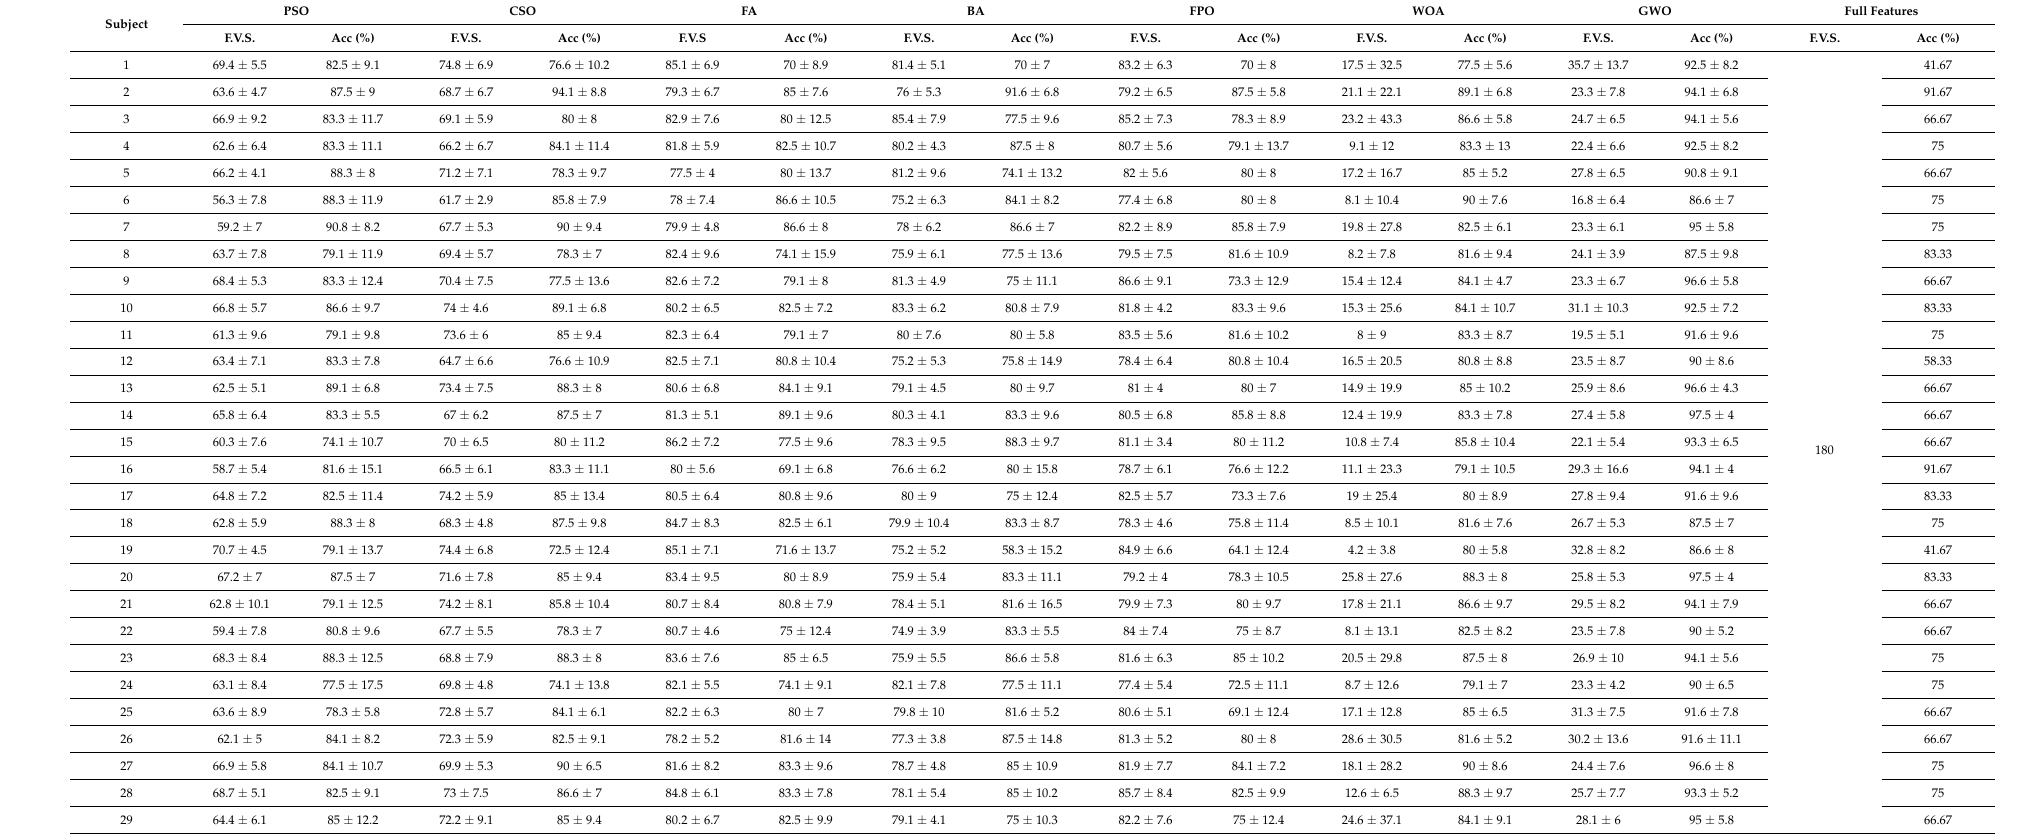
Table 3. Classification performance of each subject for the left-hand motor imagery (LHMI) and right-hand motor imagery (RHMI) tasks in terms of the accuracy (Acc) and the feature vector size (F.V.S.) (data represented as the mean ± the standard